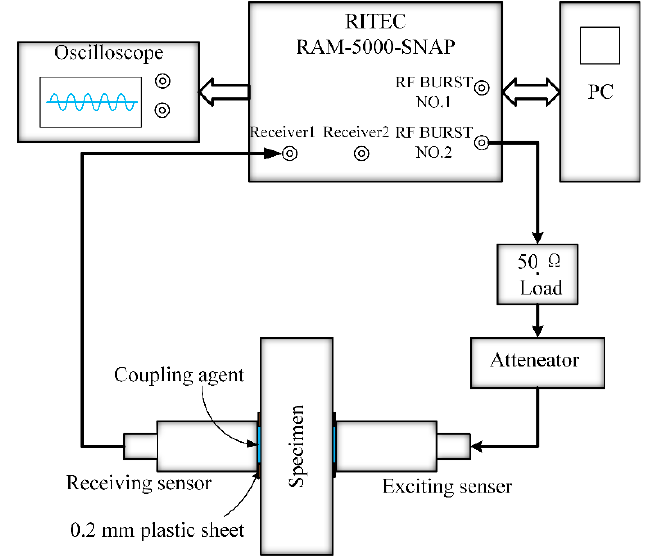
Figure 2. Schematic diagram of experimental platform.